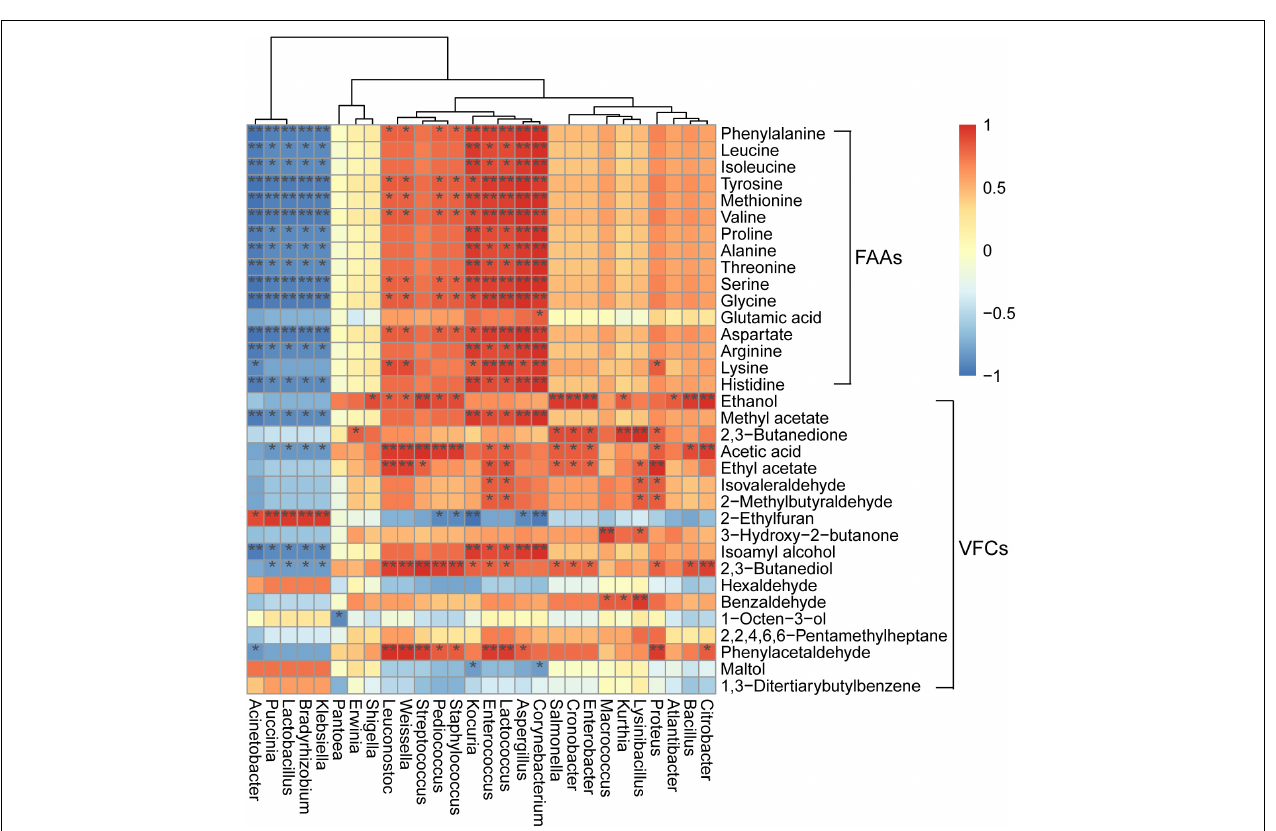
FIGURE 3 | Changes in enzyme-encoding gene abundances among fermentation stages based on annotations against the Kyoto Encyclopedia of Genes and Genomes (KEGG) database within the carbohydrate metabolism category (e.g., starch and sucrose metabolism, glycolysis/gluconeogenesis, and pyruvate metabolism). Gene abundances were normalized by calculating Z scores of the tags per million (TPM) values for each fermentation stage. Heatmap values range from + 1.5 to − 1.5 and represent high abundance to low abundance levels.